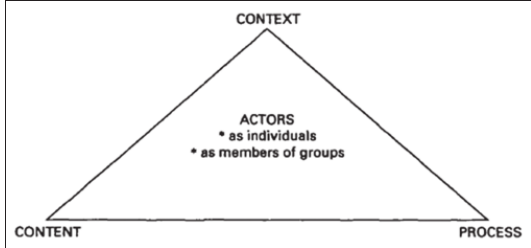
Figure 2 . Health Policy Triangle. Source. Walt and Gilson. [3]